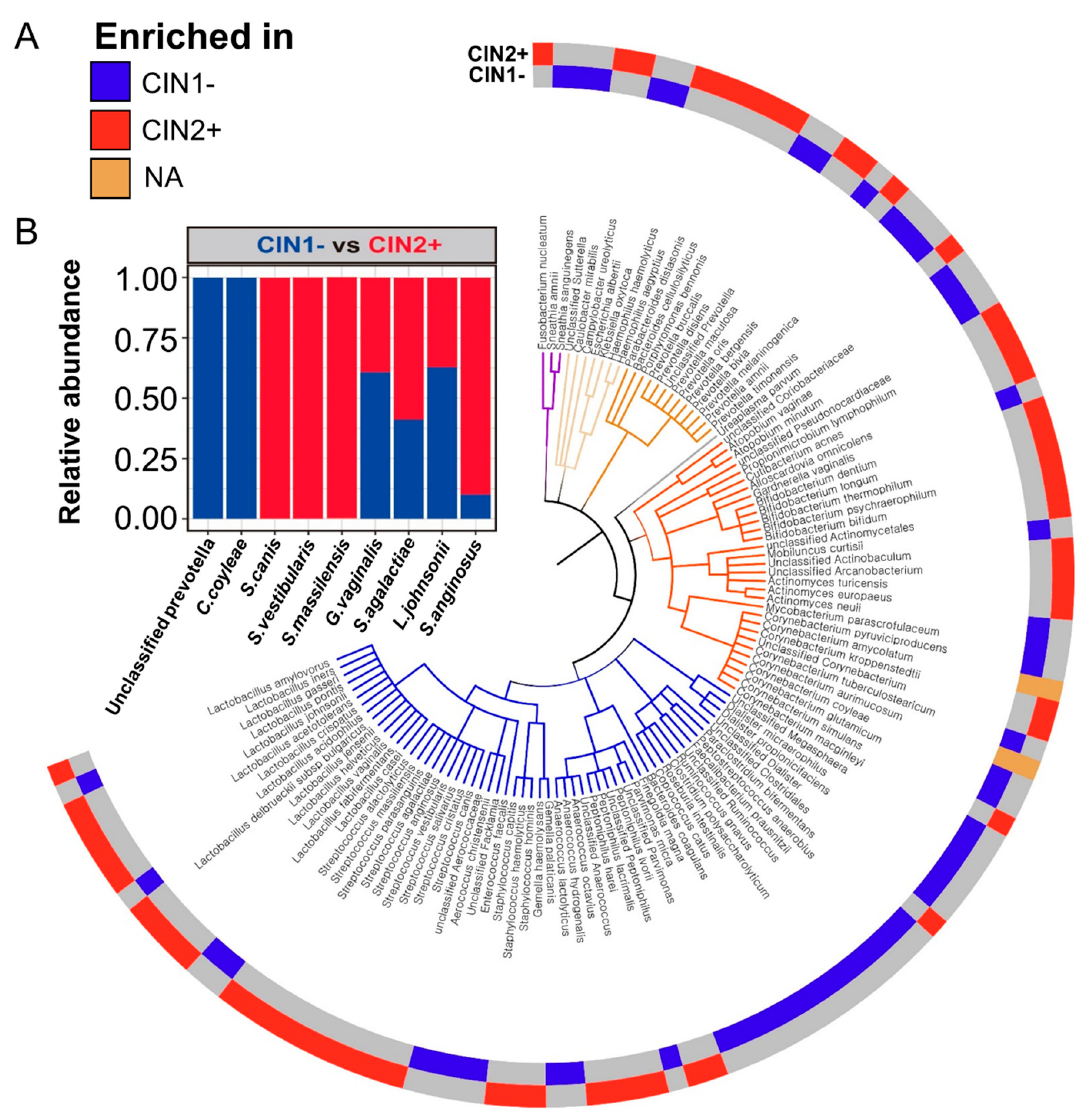
Figure 3. Bacterial differences between CIN stages. The circular phylogenetic tree at the species level is the same as shown in Figure 1. ( A ) The outer circle represents the enriched bacterial species in each CIN and ( B ) the bar charts show mean relative abundance of the most significant species in each CIN stage.